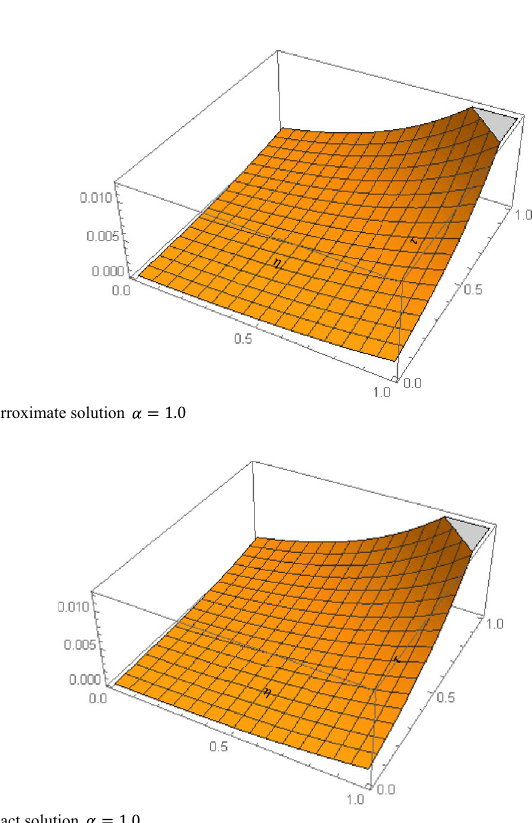
Figure 3. 2D surfaces obtain for the approximate solution of FZK(3,3,3) for altered values of α when τ = 0.1, y = 0.2.